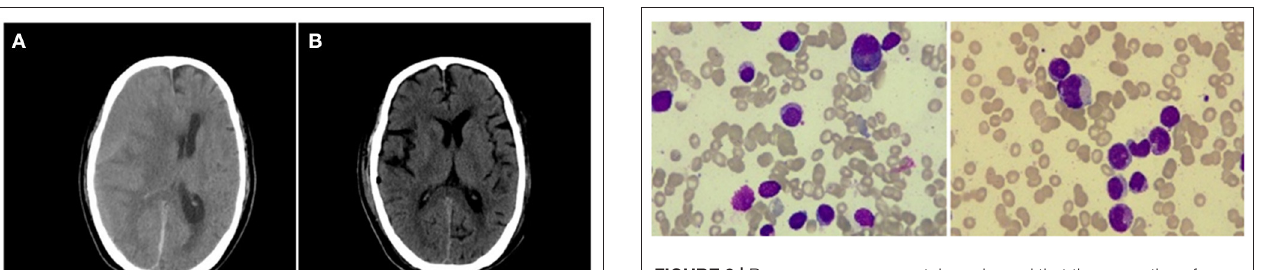
FIGURE 2 | Bone marrow smear cytology showed that the proportion of monocytes increased, with promonocytes accounting for ∼ 8.2% of these cells. The cells were variable in size and irregular, mostly with processes and varied amounts of cytoplasm. Morphological analysis of peripheral blood cells showed that the proportion of classified monocytes increased, and promonocytes were easily